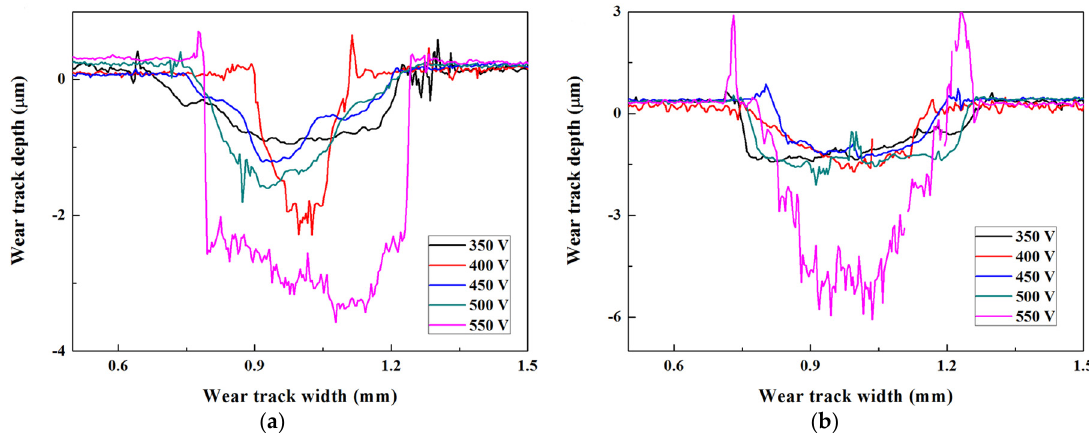
Figure 11. The 2D profile curves of the wear tracks for AlCrN coatings after wear tests under ( a ) 600 °C and ( b ) 800 °C.